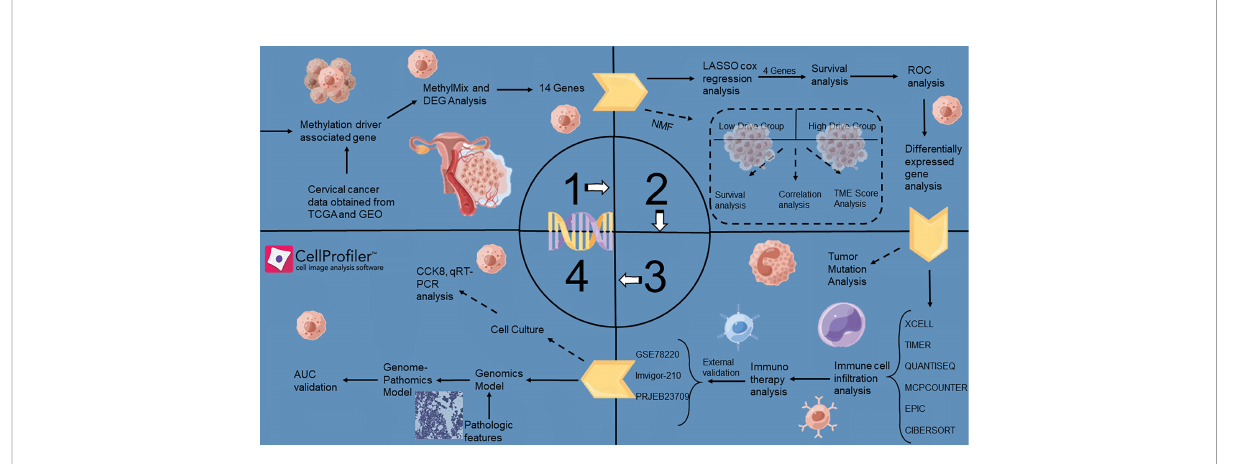
FIGURE 1 A fl owchart of the major steps in this